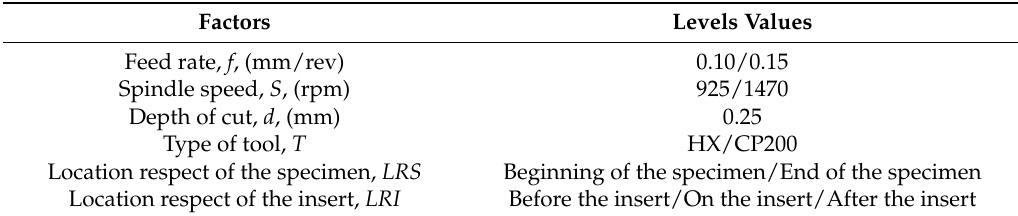
Table 4. Selected values for the levels of each factor analysed.